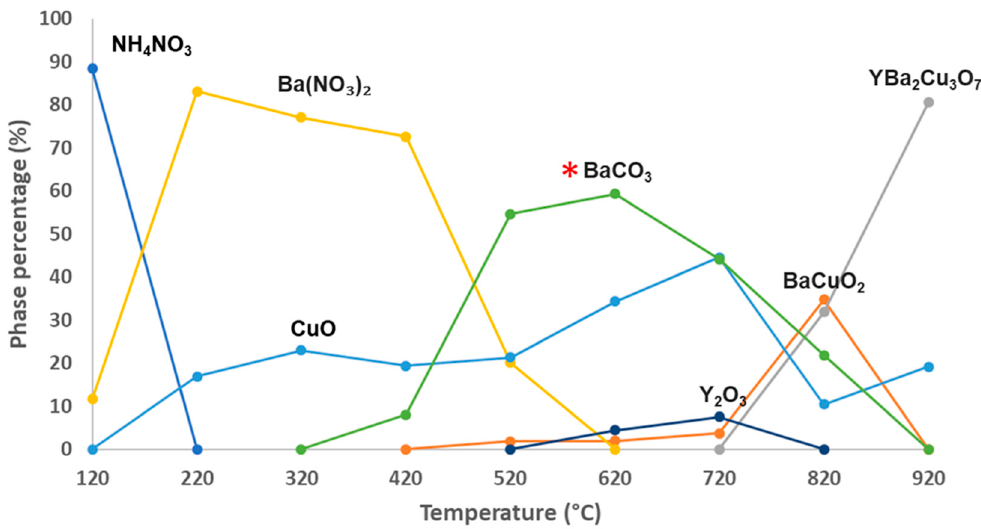
Figure 3. Graphical representation via qualitative analysis of pXRD patterns from the temperature analysis of the synthesis of YBa 2 Cu 3 O 7 − x (YBCO) (123) superconductor in the 5:1 molar ratio of ammonium nitrate / YBaCu nitrates.